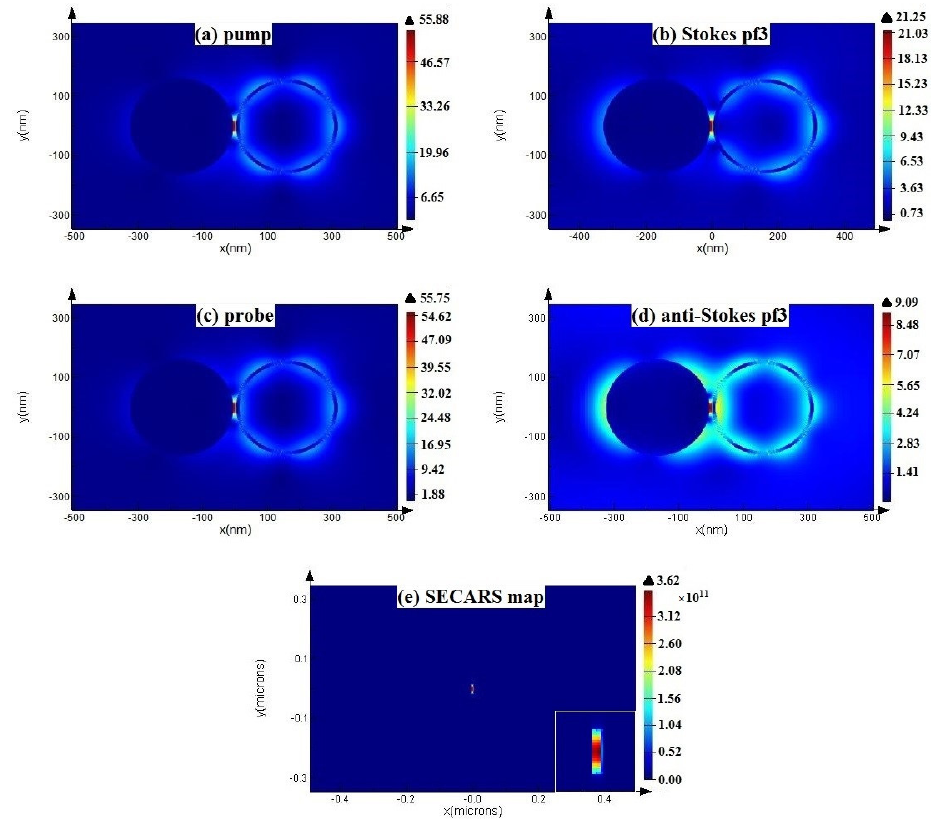
Figure A9. Transient distributions of the electric field of ( a ) pump, ( b ) Stokes, ( c ) probe, ( d ) anti-Stokes light, and ( e ) corresponding SECARS map at 7128.3 fs. The white box in ( e ) is an enlarged view of the area with 60 nm × 60 nm in the center of the disk-ring structure.